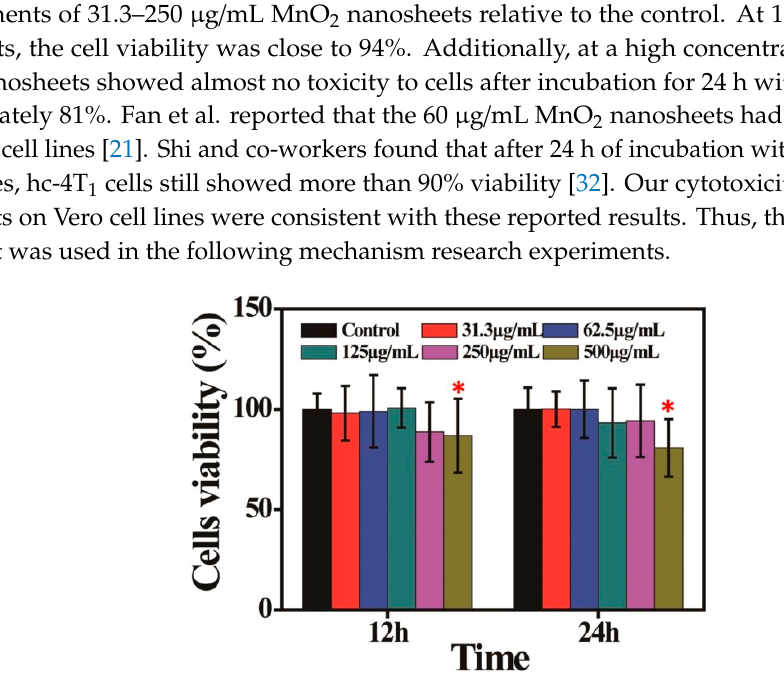
Figure 5. Fluorescence assays of live and dead Salmonella cells in the absence ( A,B ) and presence ( C,D ) of 125 μ g/mL MnO 2 nanosheets.